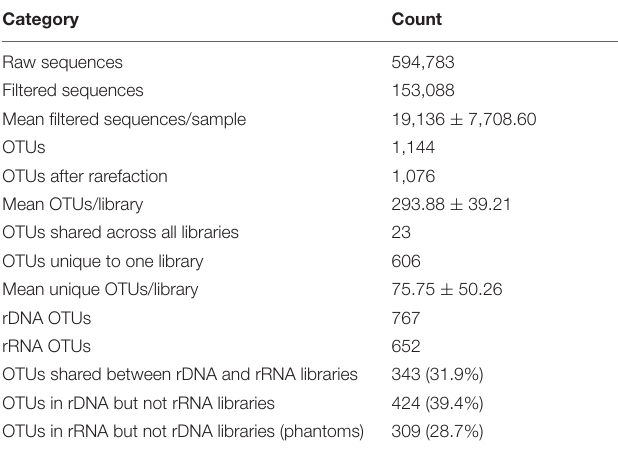
TABLE 1 | Sequence summary